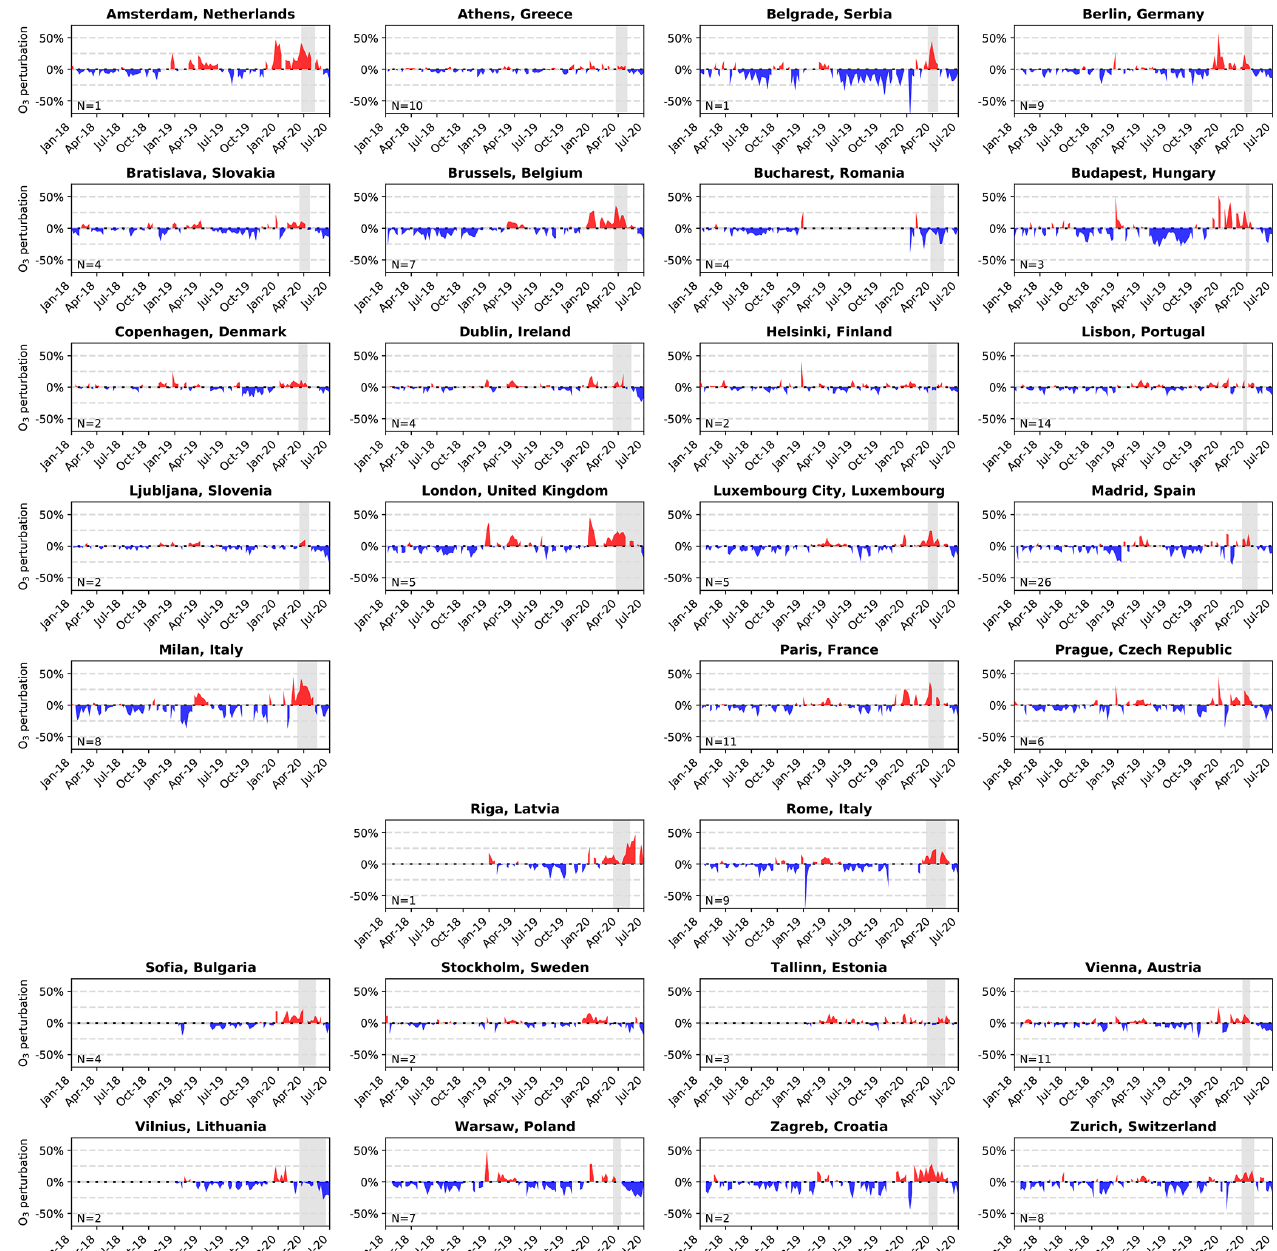
Figure A10. The same as Fig. A9 but for Europe. No observations are available for Reykjavik, Oslo, and Skopje.